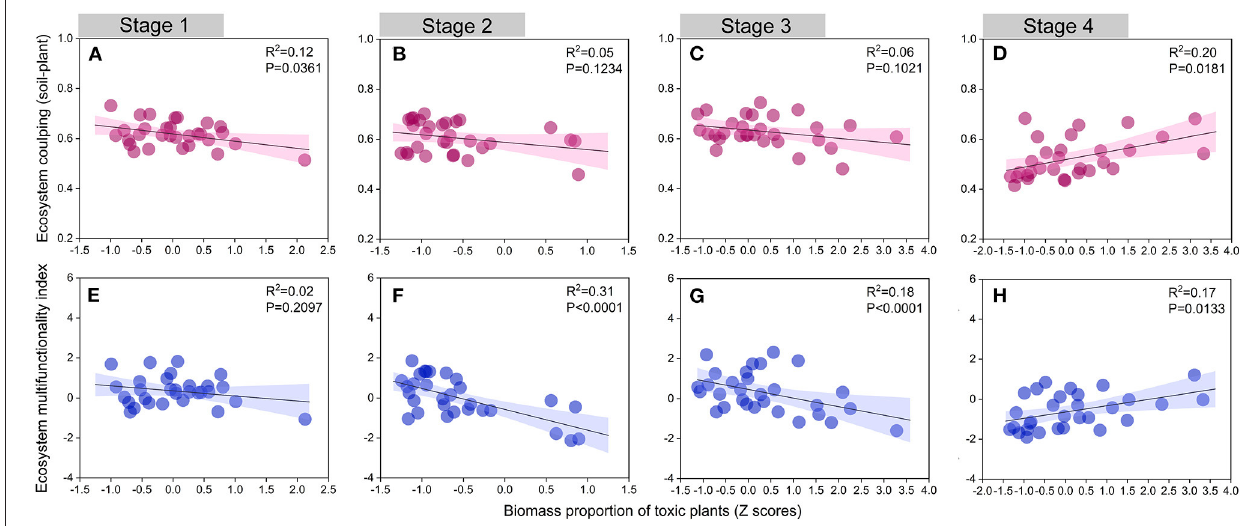
FIGURE 7 | Relationships between ecosystem coupling (soil-plant), ecosystem multifunctionality index, and biomass proportion of toxic weeds (Z scores) in different succession stages. Stage 1, (A,E) ; Stage 2, (B,F) ; Stage 3, (C,G) ; Stage 4, (D,H) .